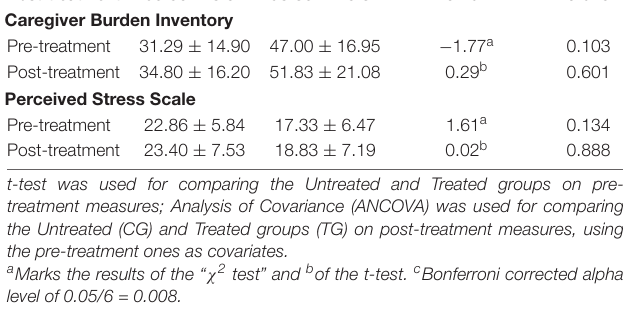
TABLE 2 | Between-group comparison on psychological measures at pre- and post-treatment assessment (using pre-treatment assessment as covariate). Variable